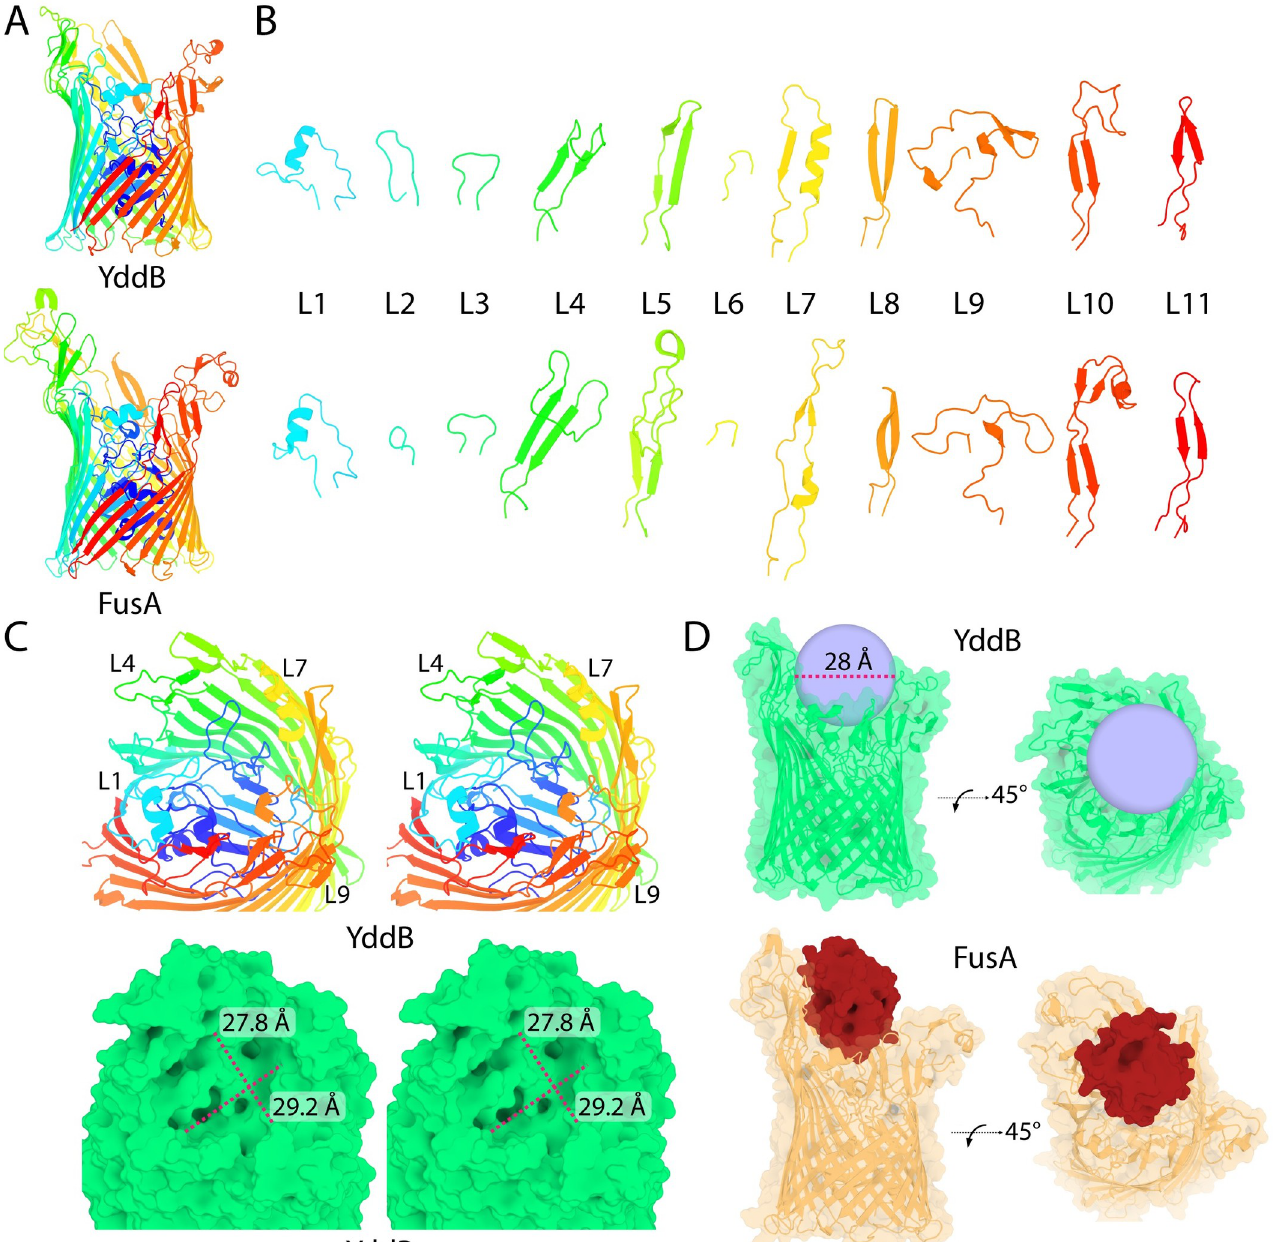
Fig 3. The crystal structure of YddB reveals structural homology to FusA, implying conserved function in protein import. (A) A cartoon representation of YddB (top) and FusA (bottom) showing structural homology between the two proteins despite limited (24%) sequence identity. (B) Dissection of the eleven extracellular loops of YddB (top) and FusA (bottom), showing that they conform to similar length and structural patterns. (C) A stereo view of the extracellular binding pocket of YddB (top = cartoon, bottom = green surface) showing that it consists of a large cavity capable of binding a small globular protein, in common with FusA. (D) Surface/cartoon representation of YddB (top), showing its extracellular binding pocket can accommodate a globular molecule ~28 Å in diameter. The structure of FusA docked with its ferredoxin substrate (bottom) is shown for reference. BamA [28]. The cytoplasmic protein YtfP was absent from the periplasmic or outer membrane fractions, demonstrating the lack of cytoplasmic contaminants in these fractions (Fig 4B) [29].